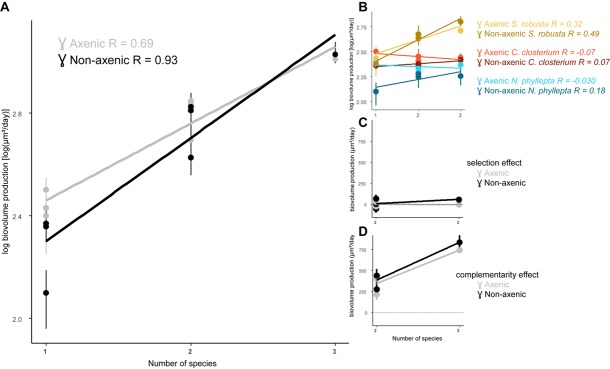
The presence of bacteria steepens the algal diversity-productivity relation. (A) Diatom biovolume production in function of species richness and its slope (m) in the presence (non-axenic, black line) or absence of bacteria (axenic, gray line). (B) Algal biovolume production per diatom species and its slope for each diatom: S. robusta (yellow), C. closterium (red), and N. phyllepta (blue). The presence or absence of bacteria are, respectively depicted as dark- and light-colored lines. The contribution of the selection and complementarity effects to diversity-productivity relation are, respectively shown in (C,D) in the presence (black) or absence (gray) of bacteria.